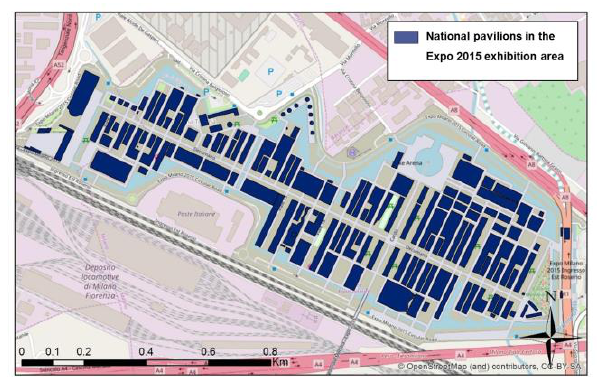
Figure 1. National pavilions inside the Expo 2015 area